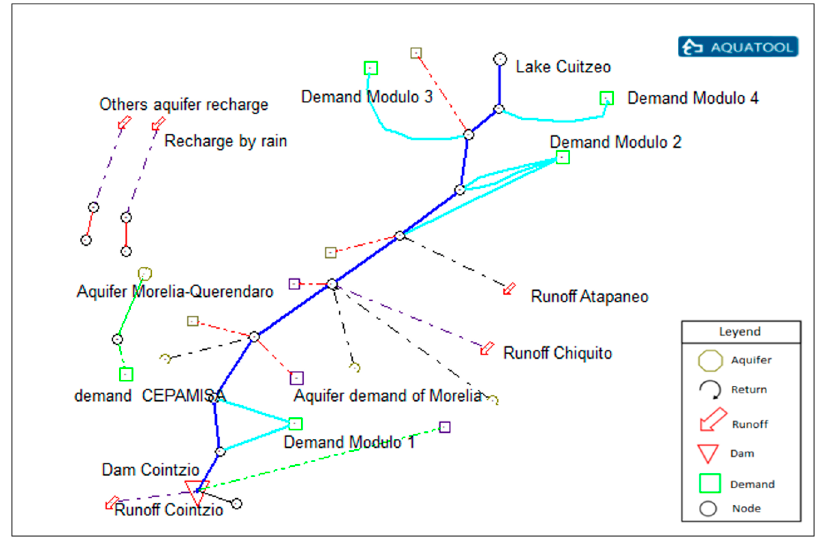
Figure 3. Schematic simulation of the basin of Rio Grande de Morelia.